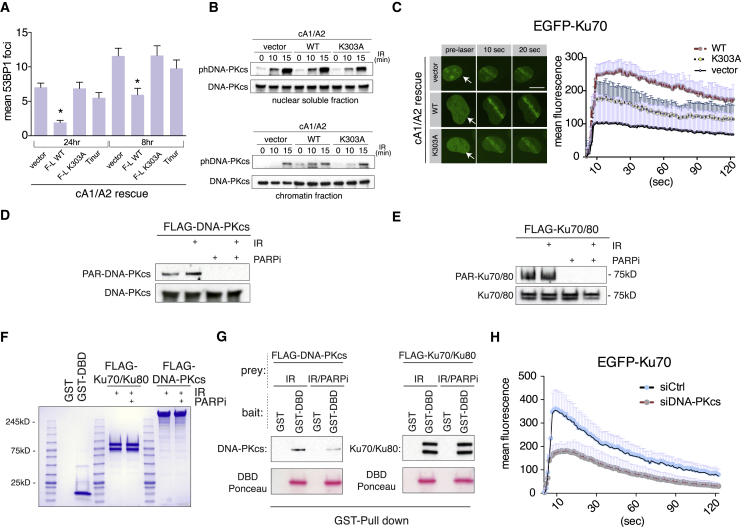
Zn2 PAR-Binding Domain of NR4A1/2 Facilitates DSB Repair by Targeting Poly-ADP-Ribosylated DNA-PKcs Protein(A) DSB levels measured as 53BP1 foci count after 8 or 24 h post-1 Gy irradiation in cA1/A2 after infection with recombinant retroviruses expressing indicated proteins (n = 3; error bars represent SEM). Asterisks denote statistically significant differences in relation to the vector control sample (p < 0.05).(B) Western blotting of DNA-PKcs and phosphor-Ser2056 DNA-PKcs (phDNA-PKcs) in cA1/A2 cells transduced with vector, WT NR4A2, or K303A NR4A2 expressing viruses at indicated time points after 10 Gy irradiation. Top panel shows the nuclear soluble fraction. Lower panel shows the chromatin fraction.(C) Laser microirradiation of transiently transfected EGFP-Ku70 fusion protein in cA1/A2 cells stably transduced with vector, WT NR4A2, or K303A NR4A2. Arrow shows the irradiated position in the nucleus. Scale bar, 10 μm. Graph presents the quantification of laser microirradiation experiments (n = 3) with SD plotted above individual data points.(D) Purified FLAG-DNA-PKcs protein from cells treated as indicated (PARPi, PARP inhibitor; IR, ionizing radiation, 20 Gy dose) were subject to western blotting with indicated antibodies.(E) As in (D) with purified FLAG-Ku70/Ku80 complex.(F) Coomassie staining of indicated protein preparations (glutathione S-transferase [GST]/GST-DBD NR4A2 shows these proteins after PreScission protease cleavage that releases DBD from GST).(G) GST pull-downs were performed with either GST or GST-DBD NR4A2 (aa 245–360)-bound beads (baits) incubated with indicated prey proteins. Bound material was eluted from GST beads by PreScission protease cleavage and either probed by western blotting for the presence of the DNA-PKcs/Ku complex or stained with Ponceau S to determine the efficiency of bait cleavage.(H) Laser microirradiation of transiently transfected EGFP-Ku70 fusion protein in U2OS cells pre-transfected for 48 h with control (siCtrl) or DNA-PKcs-specific siRNA (siDNA-PKcs). Graph presents the quantification of laser microirradiation experiments (n = 3) with SD plotted above individual data points.